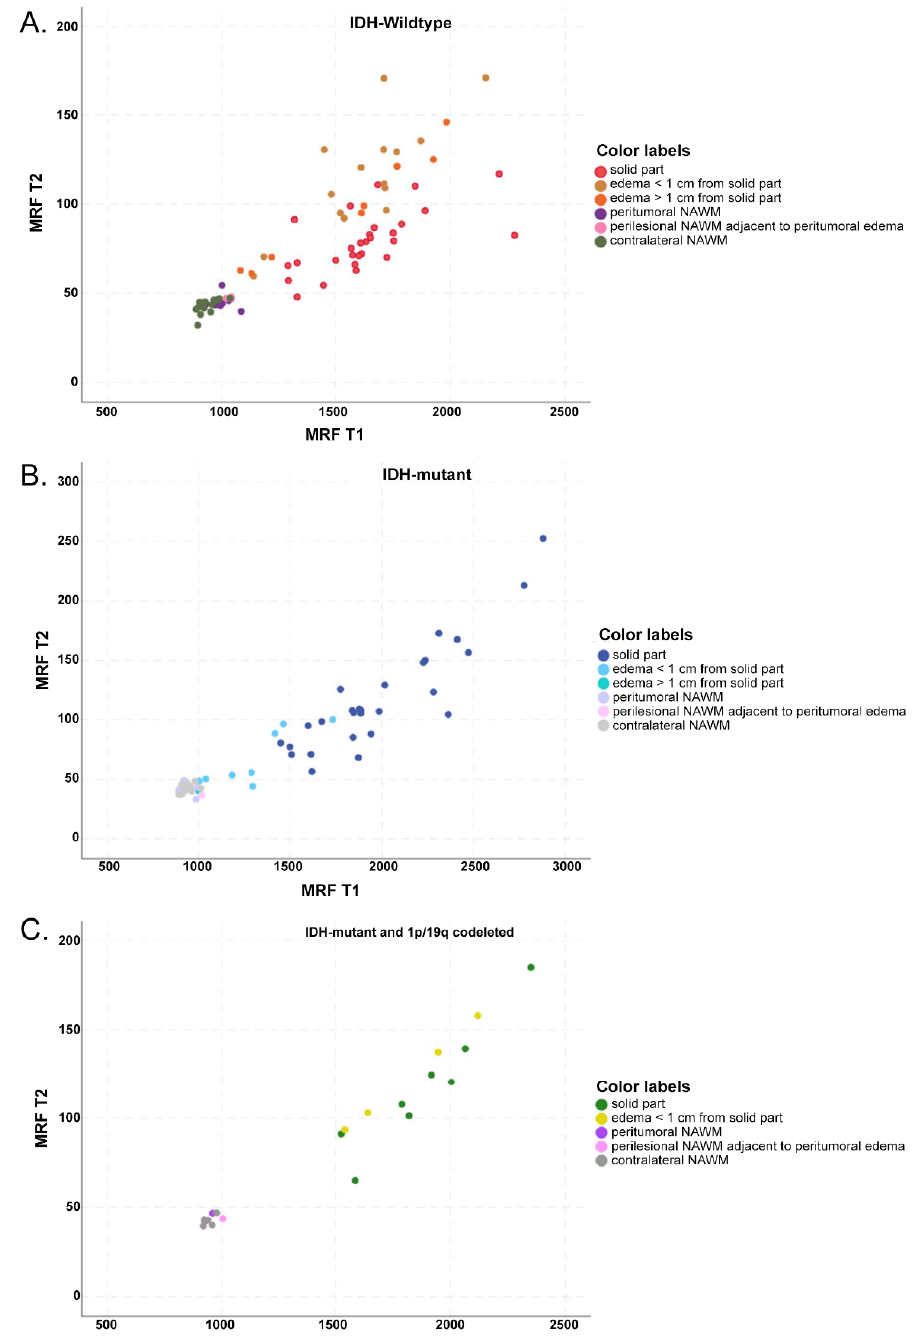
Figure 6. Scatterplot of MRF T1 and T2 relaxation time values in IDH-wildtype ( A ), IDH-mutant ( B ), and IDH-mutant 1p/19q codeleted gliomas ( C ) from different types of tissue (solid part of the tumor; peritumoral edema ≤ 1 cm distant from the tumor and > 1 cm distant from the tumor; perilesional NAWM ≤ 1 cm distant from the tumor or peritumoral edema; and contralateral NAWM). Significant difference for MRF T1 and T2 between solid parts of the tumor and NAWM in the IDH-wildtype and IDH-mutant, including 1p/19q-codeletion. Also notice the significant difference for MRF T1 and T2 between solid tumor components and peritumoral edema in IDH-mutant, and for MRF T2 between solid tumor components and peritumoral edema in the IDH-wildtype (when divided into sub-specified areas of peritumoral edema, significant only in edema ≤ 1 cm distant from the solid